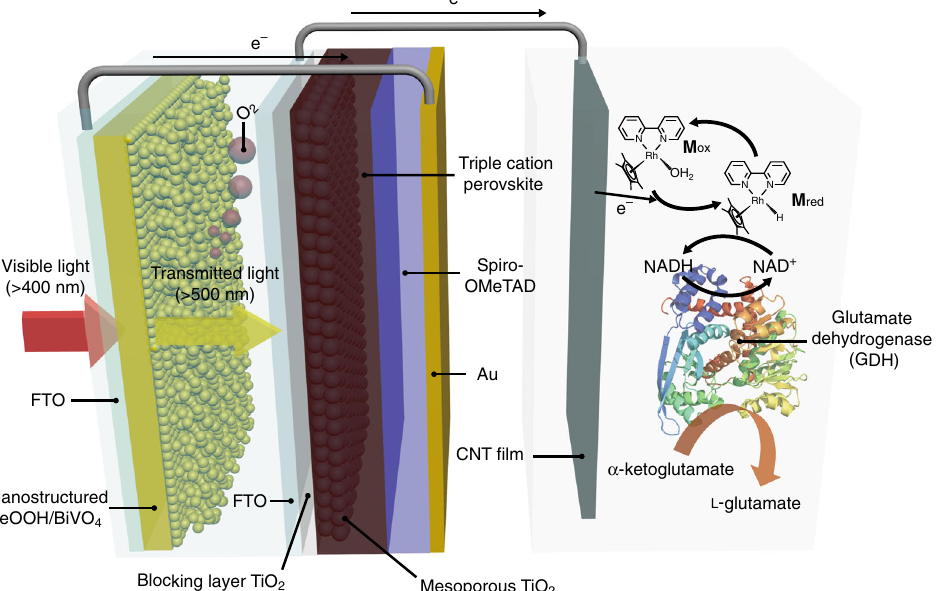
Fig. 1 Graphical illustration of unbiased PEC biocatalysis using a tandem con fi guration. The FeOOH/BiVO 4 /perovskite tandem structure promotes PEC water oxidation and the CNT fi lm cathode provides photoexcited electrons for the regeneration of NADH cofactors to be coupled with redox enzymatic reaction by